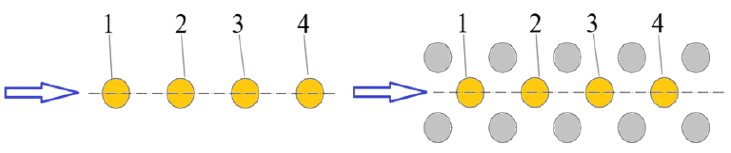
Figure 8. Lengthwise and checkerboard pattern of tube position.